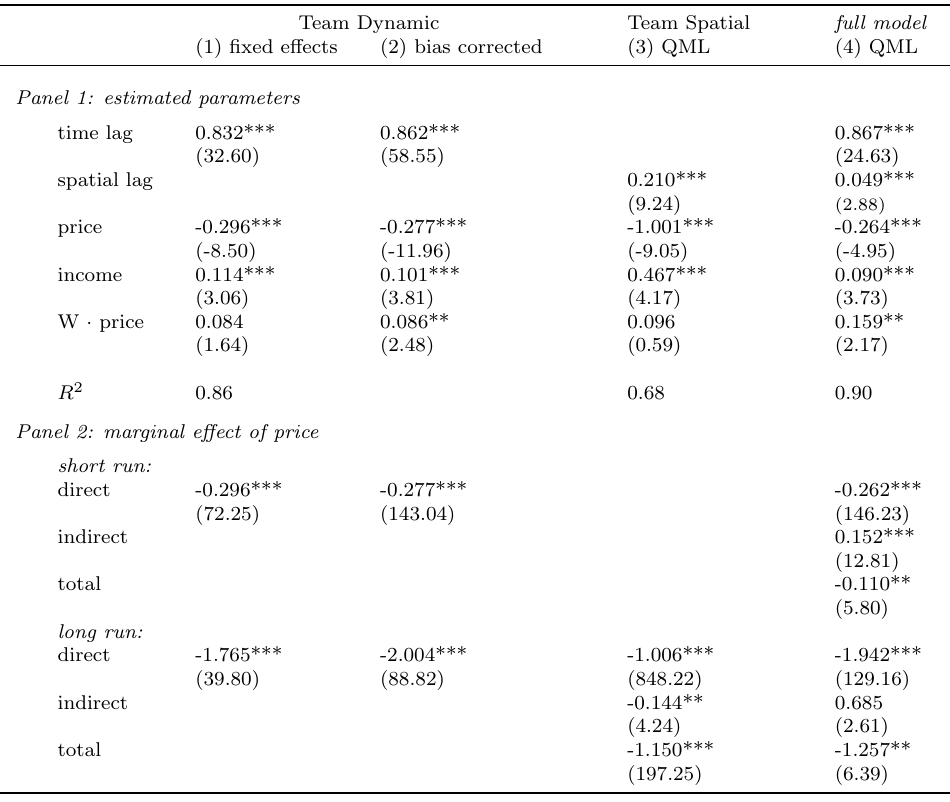
Table 5: Empirical illustration; dependent variable: log consumption per capita Team